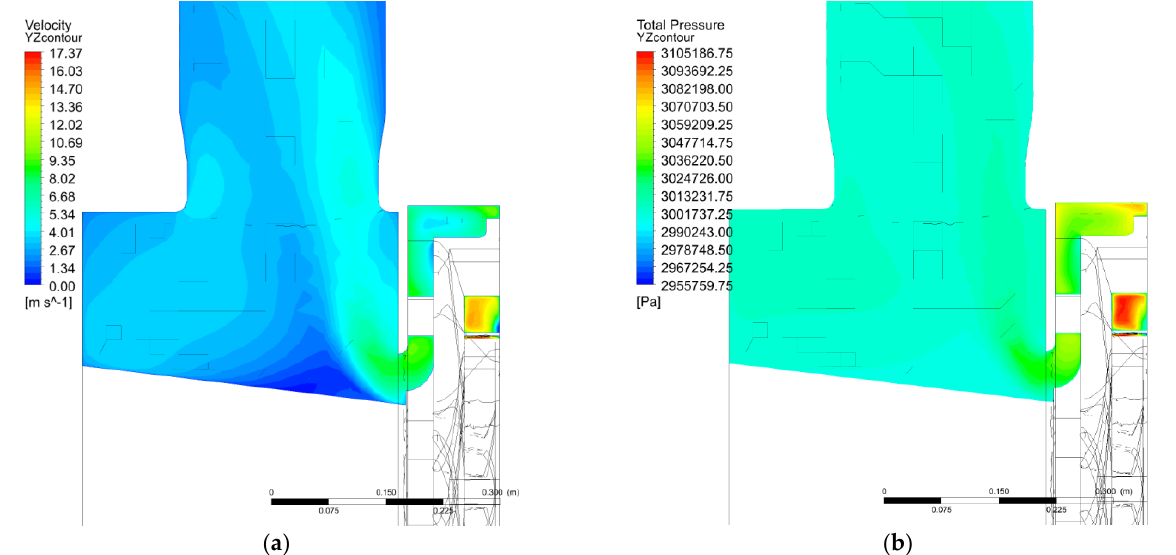
Figure 5. Results of the transfer and outlet channels of the outlet device: ( a ) a qualitative picture of the relative velocity distribution; ( b ) a qualitative picture of pressure distribution.